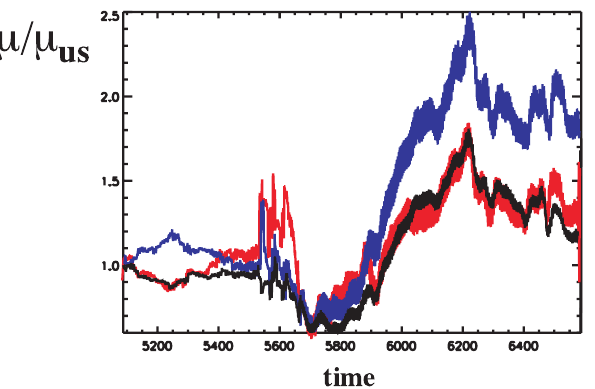
Fig. 4. Time evolution of the magnetic moment ratio µ/µ us for the same selected particles of Fig. 3 (panels g, h, i) in absence of the electrostatic field component ( e E lx = 0). In order to emphasize the differences with Fig. 3, the same color code for the curves (black, red and blue) is used.